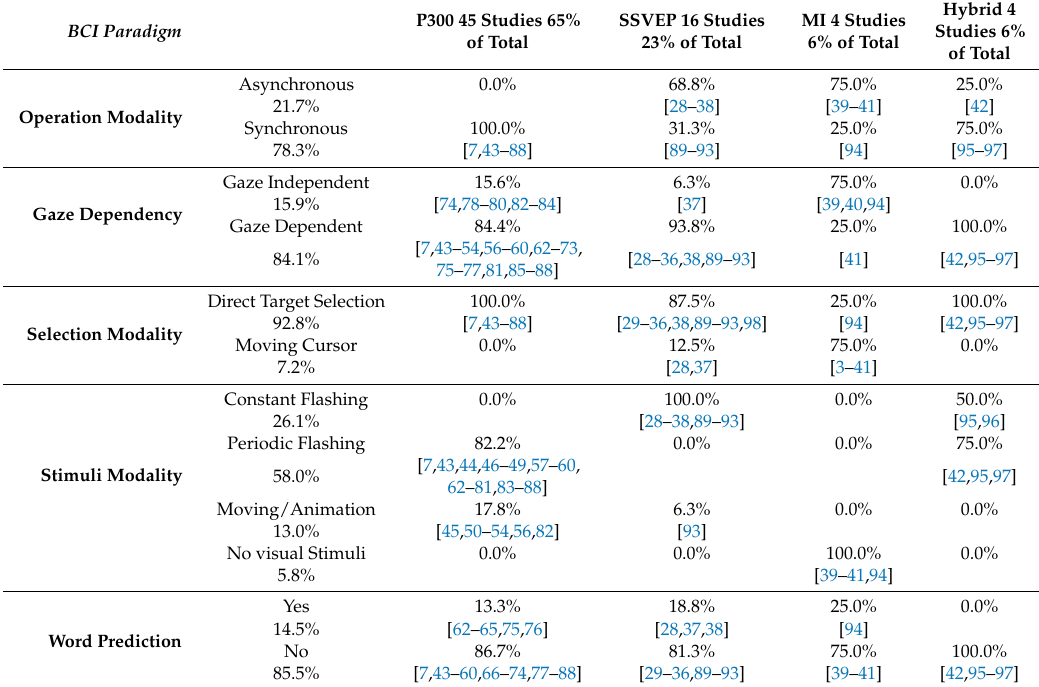
Table 1. BCI spellers’ taxonomy. The table also classifies the papers presented in this review according to the suggested